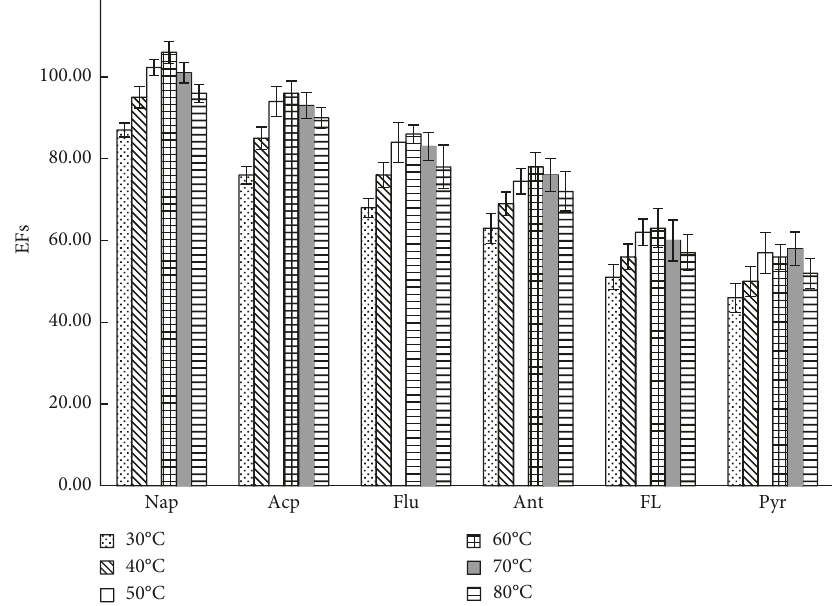
Figure 4: The effect of temperature on EFs. Other extraction conditions:10 mL of aqueous standards (containing PAHs at a concentration of 5 μ g · L − 1 ); extraction temperature, 50 ° C; extraction solvent volume, 50 μ L; extraction time, 30 min; the concentration of NaCl, 25%. Values are mean of n � 3